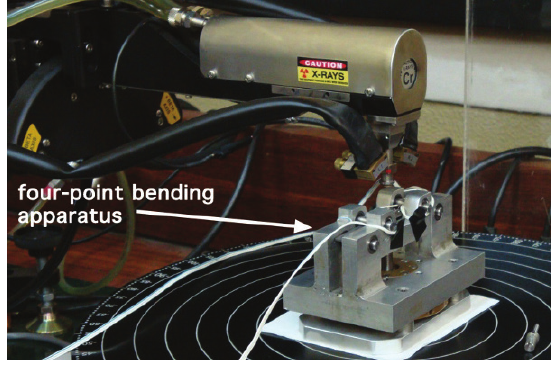
Figure 3– Proto iXRD and four point bending device.